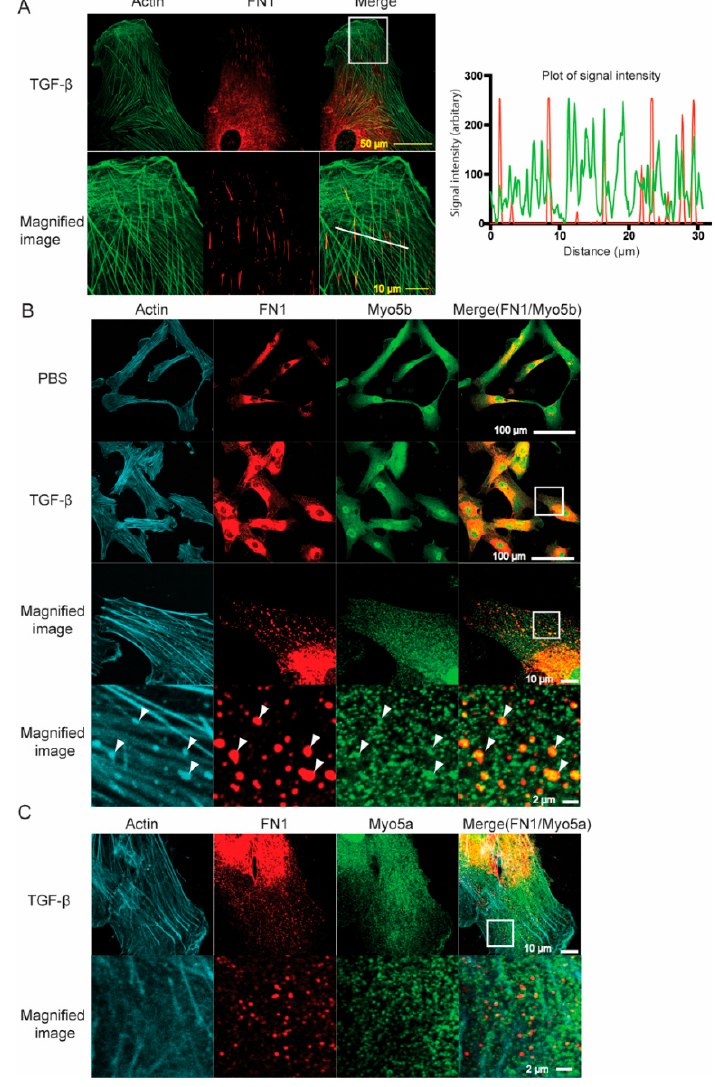
Figure 3. Colocalization of Myo5 isoforms and FN1 in HPMCs. ( A ) Confocal images of FN1 and actin in HPMCs after TGF- β stimulation. Left panel, confocal images. Bottom panels are magnified images of the white box of the top panel; right panel, signal intensities of FN1 (red) and actin (green) of the white line in the left panel. Distance 0 represents the left end of the white line. Note that FN1 showed apparent filamentous localization that coincided with actin filaments. Representative image of n = 6 cells. ( B ) Confocal images showing the localization of endogenous FN1 (red) and endogenous Myo5b (green) in HPMCs in the absence and presence of TGF- β (5 ng/mL) for 48 h. TGF- β stimulation increased the signal intensity of FN1. DAPI (blue), actin (cyan). Scale bars, 100 µ m. Middle panels: Magnified images correspond to the white square of upper panel. Bottom panels: Further magnified image that corresponds to the white square area of the middle panel. Myo5b was colocalized with FN1-containing vesicles (indicated by arrow heads) along with actin fibers. Scale bar, upper panels: 100 µ m, middle pannels: 10 µ m, lower panel: 2 µ m. Representative images of n = 3 cells for PBS, n = 6 cells for TGF- β . ( C ) Confocal images showing the localization of endogenous FN1 (red) and endogenous Myo5a (green) in HPMCs in the presence of TGF- β (5 ng/mL) for 48 h. Myo5a was not notably colocalized with FN1 after TGF- β stimulation. Scale bar, Upper: 10 µ m, Lower: 2 µ m. Representative image of n = 3